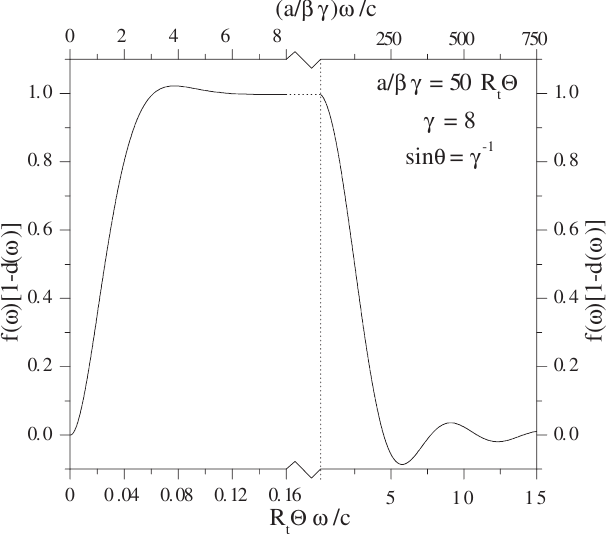
FIG. 4. Plot of temporal electric field, with coherent diffraction radiation taken into account. The long negative pulse is due to CDR. The CTR pulse is shown in the inset in the upper right corner. The parameters used to make the plot are listed in the upper left corner.